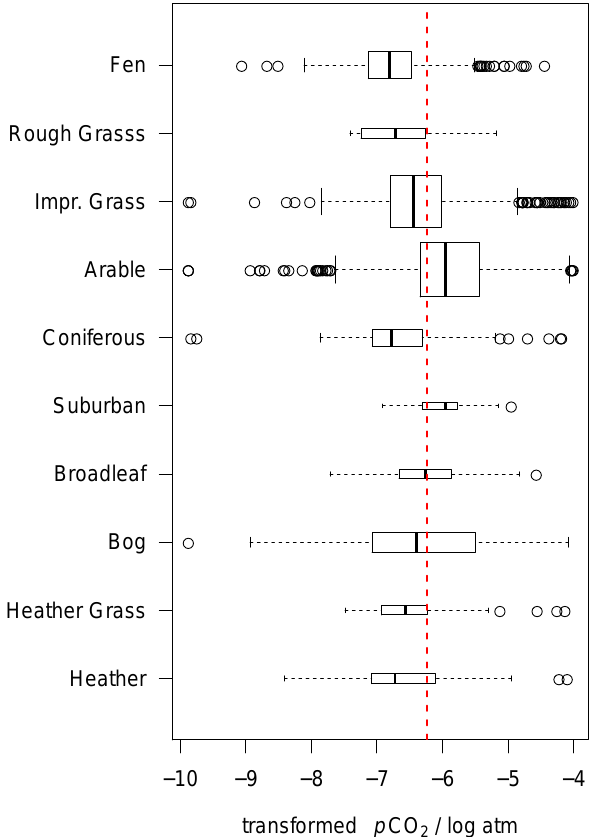
Fig. 4. Boxplot of headwater stream p CO 2 concentrations by dom- inant land cover class for each catchment ( n =2637) based on broad habitat types. Box widths are proportional to number of samples in each class. The red dashed line is the overall median of the